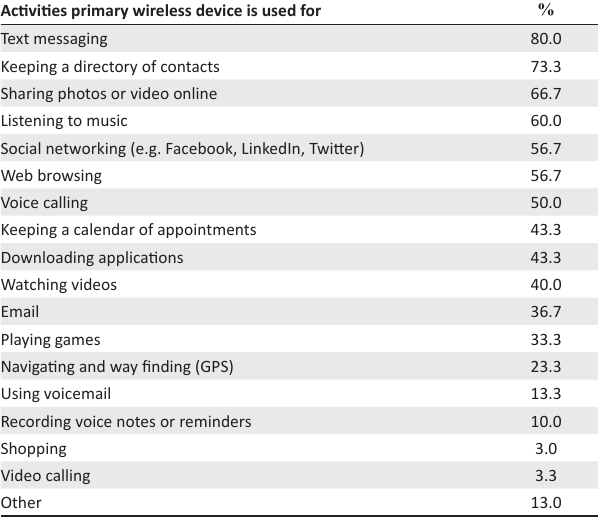
TABLE 6: Participants’ wireless activities and their frequency of use ( N =